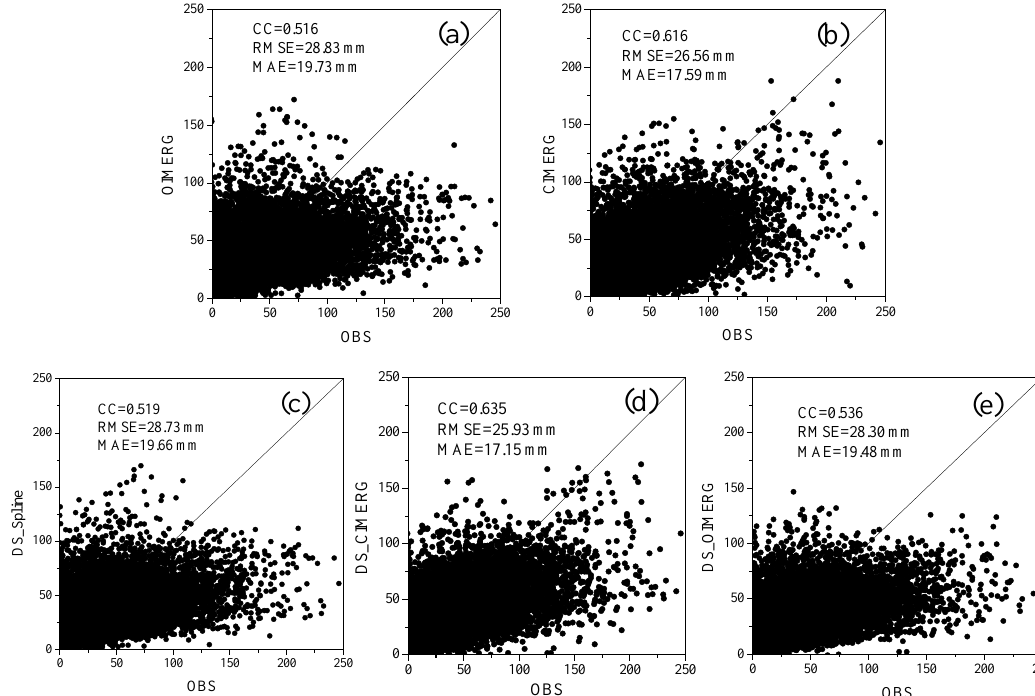
Figure 7. Scatter diagrams of the ( a ) OIMERG, ( b ) CIMERG, ( c ) DS_Spline, ( d ) DS_CIMERG, and ( e ) DS_OIMERG precipitation products against the observed precipitation during the warm seasons from 2014 to 2018. OIMERG, original IMERG precipitation data; CIMERG, OI-corrected IMERG precipitation data; DS_Spline, obtained by using the spline interpolation method for OIMERG precipitation downscaling; DS_CIMERG, obtained via GWR downscaling with CIMERG; DS_OIMERG, obtained via GWR downscaling with OIMERG; OBS, observed precipitation data.